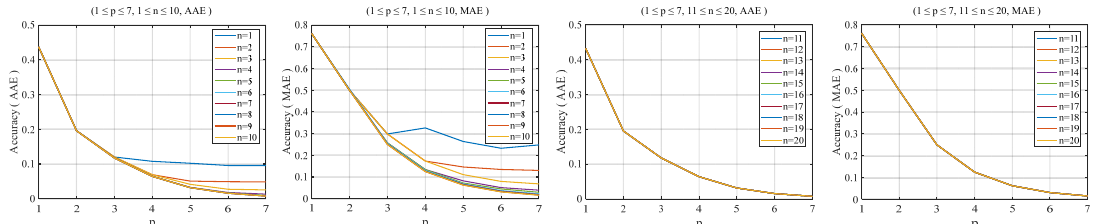
Figure 4. Sigmoid : Accuracy distribution corresponding to Case 1.